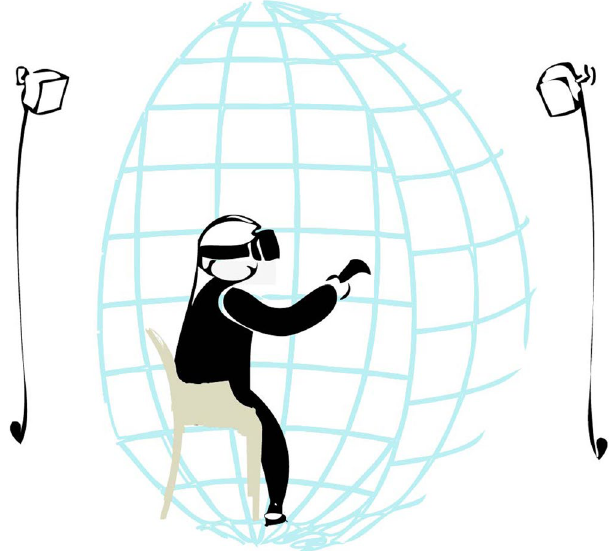
Figure 5. Stimuli rendering setup. Participants could look freely around the 185 degrees of stereoscopic video surrounding them through natural head movements and matched audio-visual digital panning, and performed the task using the HTC Vive